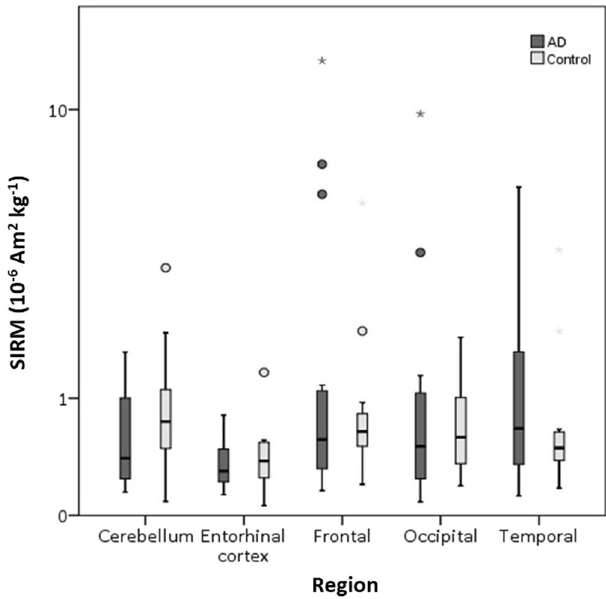
control brains from the cerebellum (n = 17 AD, 11 Control), entorhinal cortex (n = 17 AD, 9 control), frontal lobe (n = 19 AD, 11 control), occipital lobe (n = 18 AD, 10 control), and temporal lobe (n = 18 AD, 11